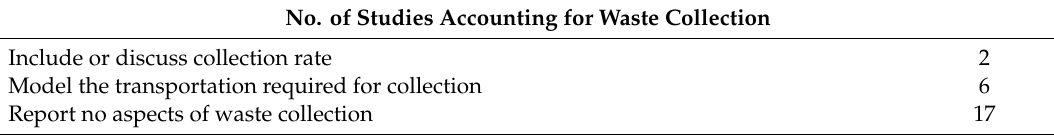
Table 2. Summarized results for the number of studies accounting for waste collection of LIBs (relevant for all 25 studies) and modelling specific procedures and materials in the recovery of LIB cells (relevant for the 19 studies modelling the EOL recycling